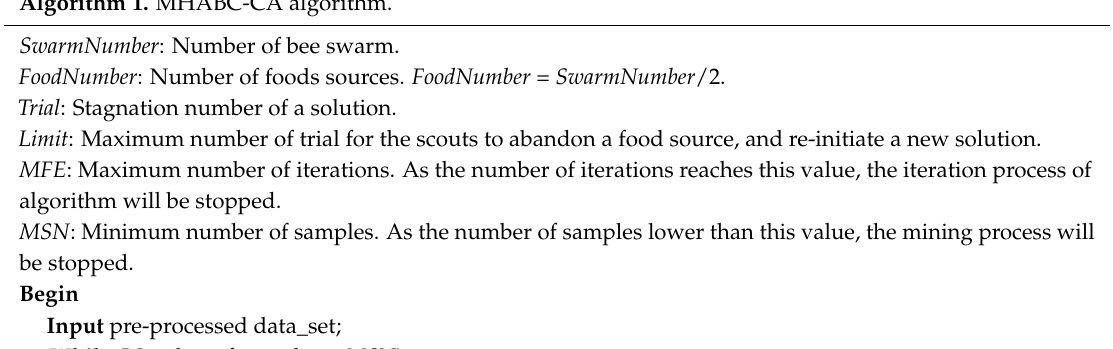
Algorithm 1. MHABC-CA